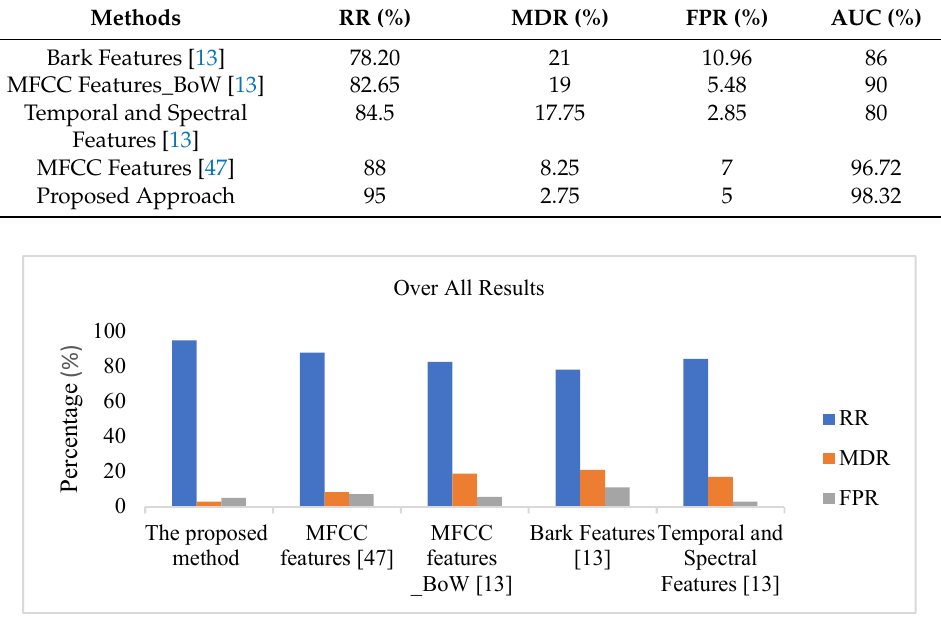
Figure 4. Comparison of performance results.